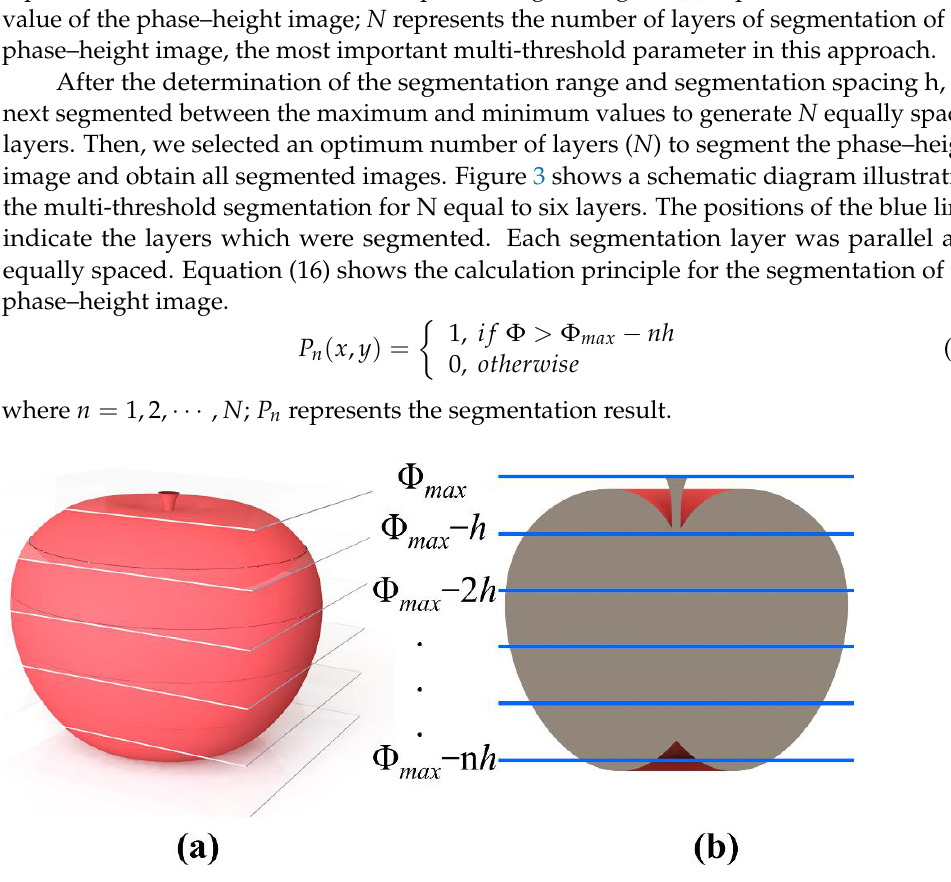
Figure 3. Demonstration of multi-threshold hierarchical processing. ( a ) Segmented three-dimen- sional image; ( b ) generalized segmented schematic. image; ( b ) generalized segmented